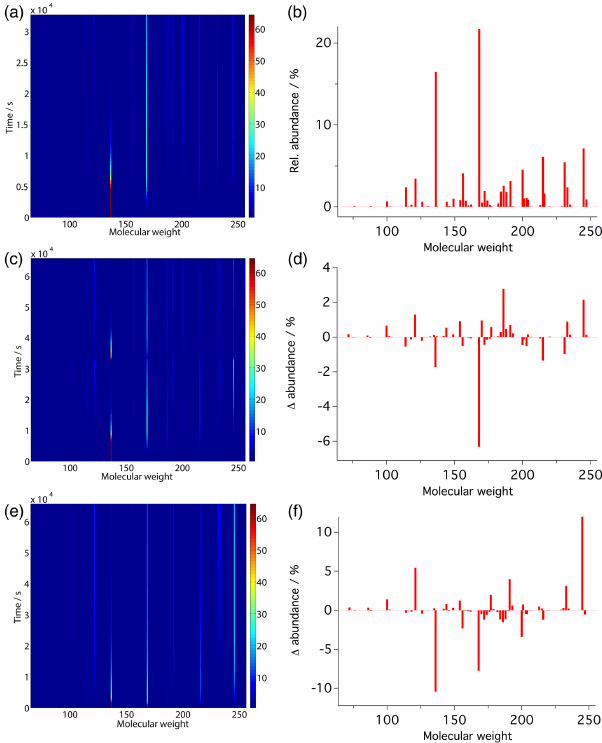
Figure 11. Results from MCM α -pinene photooxidation simula- tions. (a) and (b) represent basic α -pinene photooxidation; (c) and (d) – spiked injection of α -pinene, continuous HONO input; (e) and (f) – continuous α -pinene and HONO input. Left-hand image plots show the evolution of the respective systems over the molecular weight region of interest with time; colour scale represents relative abundance (%). Right-hand plots represent (b) relative abundance of simulated molecular weights during straight α -pinene photooxi- dation; (d) difference in relative abundance of simulated molecular weights between double injection of α -pinene continuous HONO input and straight α -pinene photooxidation; (f) difference in rela- tive abundance of simulated molecular weights between continuous α -pinene and HONO input and straight α -pinene photooxidation. See text for